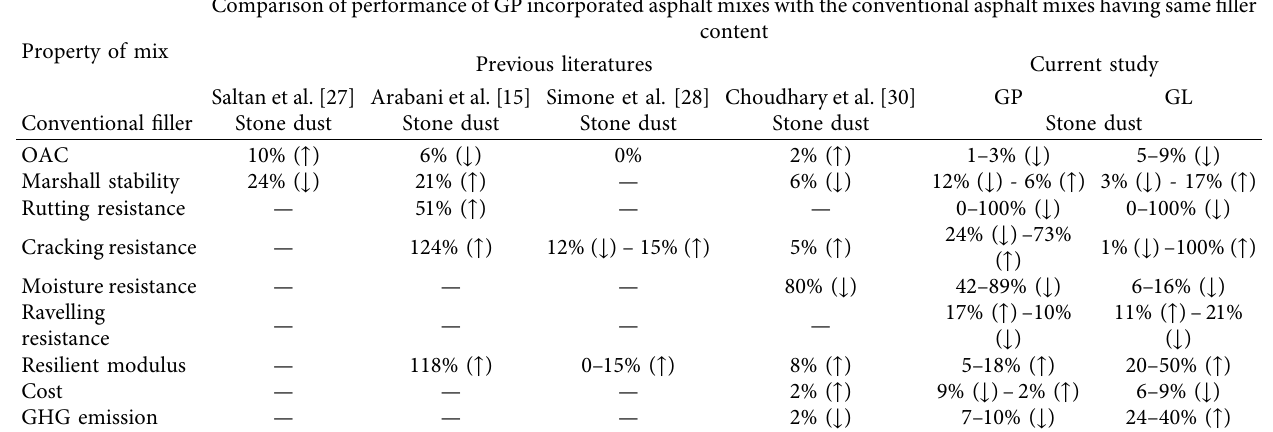
Table 11: Comparison of results of this study with the previous